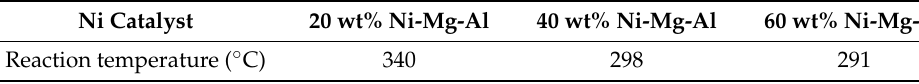
Table 1. Reaction temperatures to reach 50% CO 2